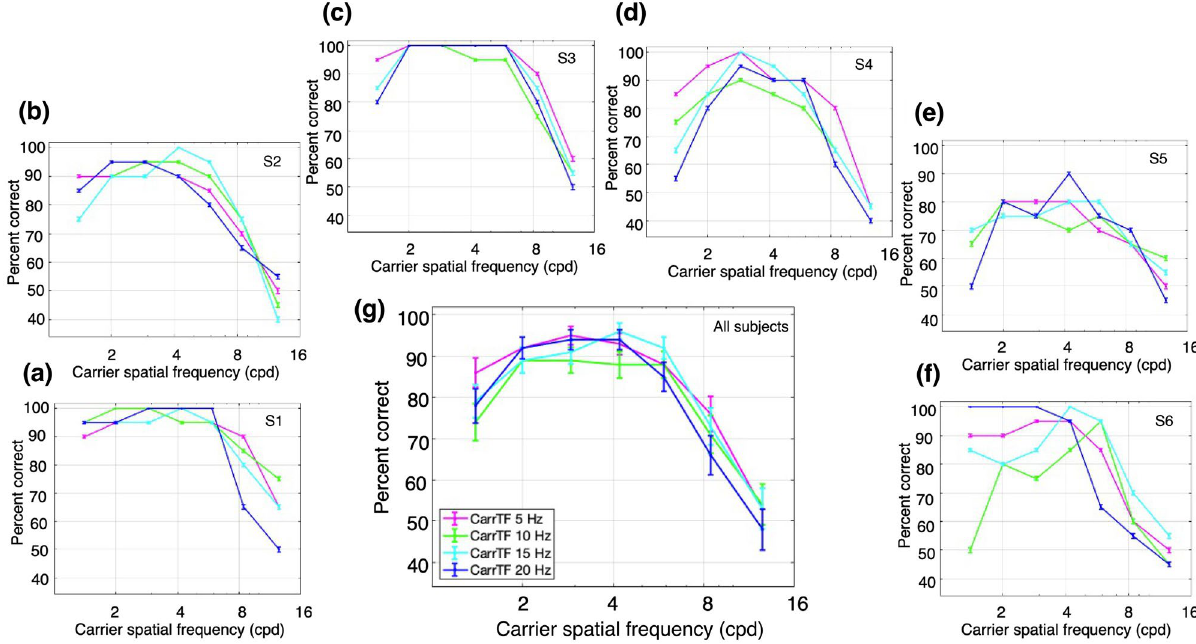
Figure 4. Performance for contrast modulation (CM) stimuli. The stimuli consisted of a contrast-reversing grating (carrier) modulated by a drifting sinewave envelope with a SF of 0.50 cpd and a TF of 3 Hz. The task was to discriminate the direction of motion of the envelope of a CM stimulus presented monocularly at 4.3° of eccentricity. Percent correct responses were measured while varying carrier SF (cpd) within blocks for different values of carrier TF: magenta, 5 Hz; green, 10 Hz; cyan, 15 Hz; and dark blue, 20 Hz. ( a – f ) Percent correct responses for subjects 1 (S1) through 6 (S6). ( g ) Mean percent correct responses of the six subjects. Error bars represent the binomial SE of each condition for each subject ( a – f ) and the SEM (N = 6 subjects) for the subject- averaged results ( g ).